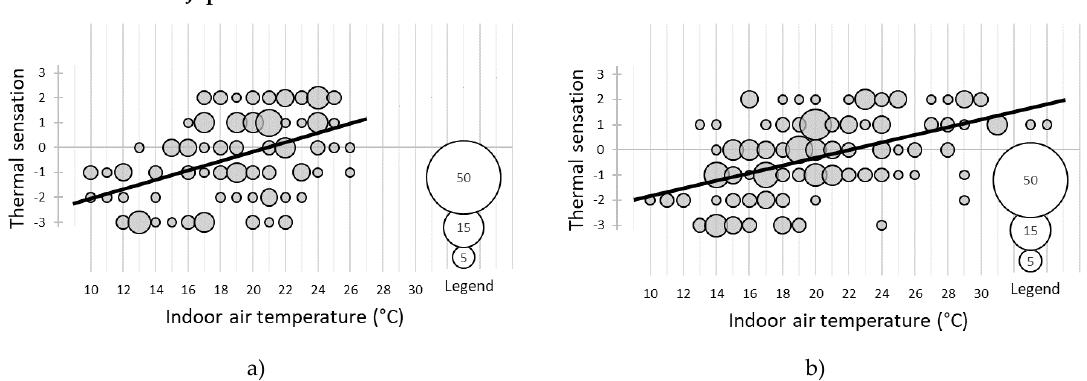
Figure 13. Thermal sensation votes: ( a ) The correlation between TSV and indoor air temperature at the vote for Japanese subjects; ( b ) the correlation between TSV and indoor air temperature at the vote for international subjects.